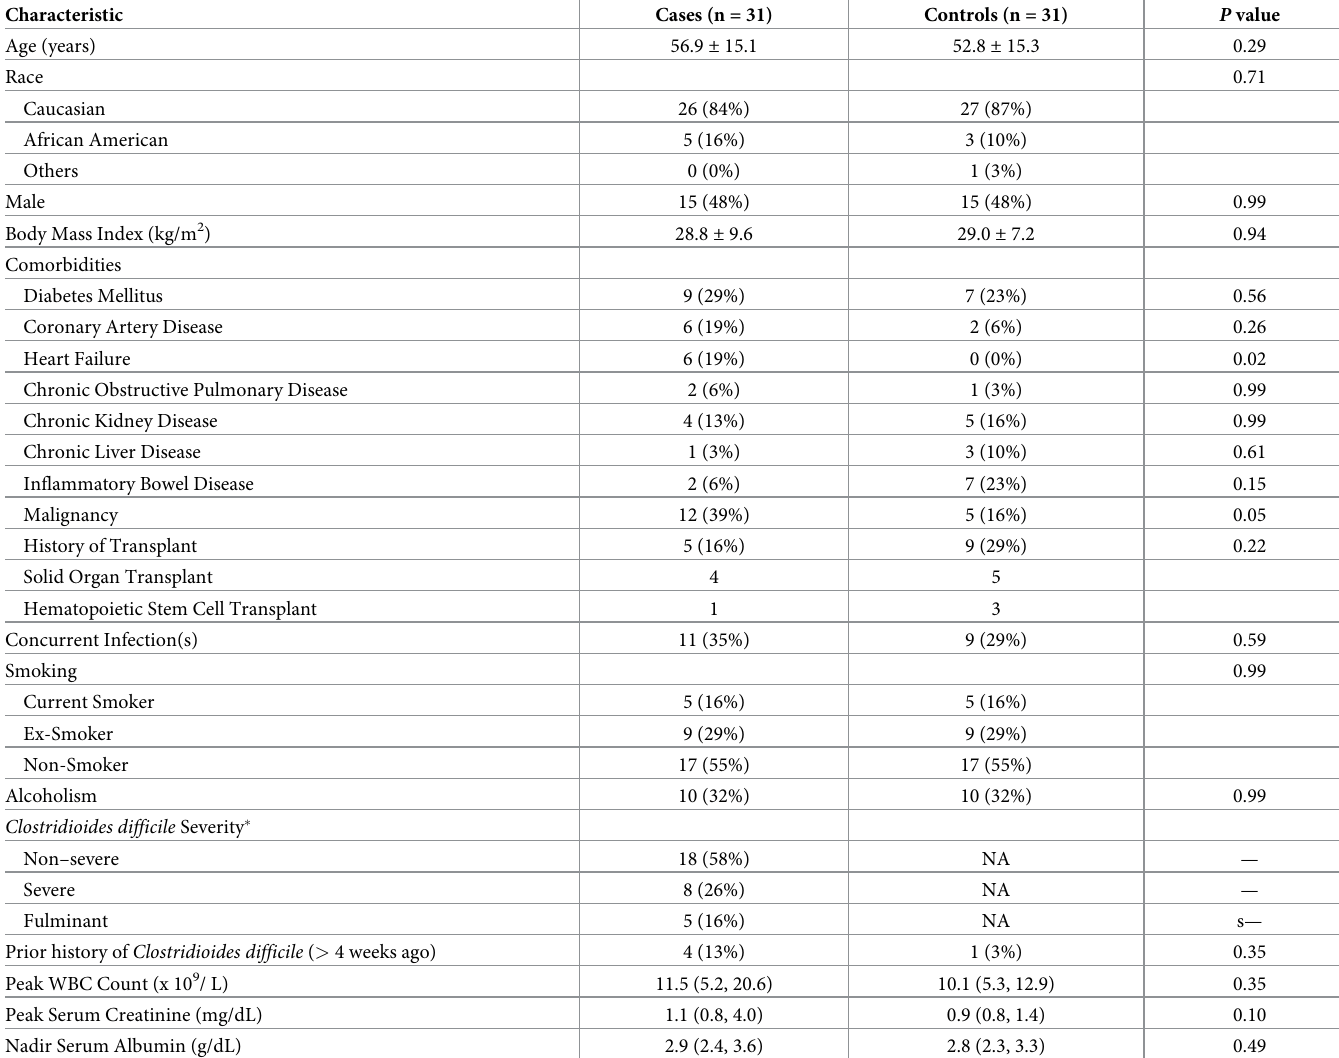
Table 1. Baseline demographic